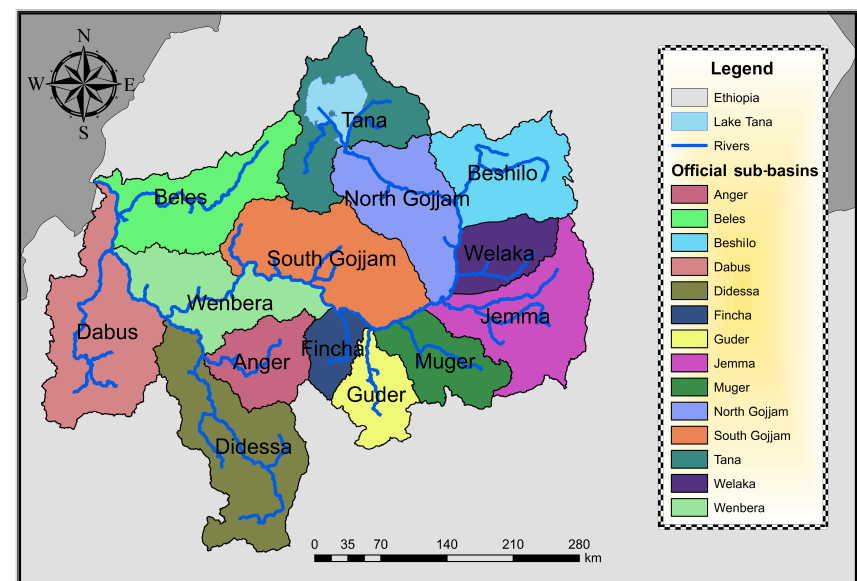
Figure 1. Official sub-basin distribution of the upper Blue Nile